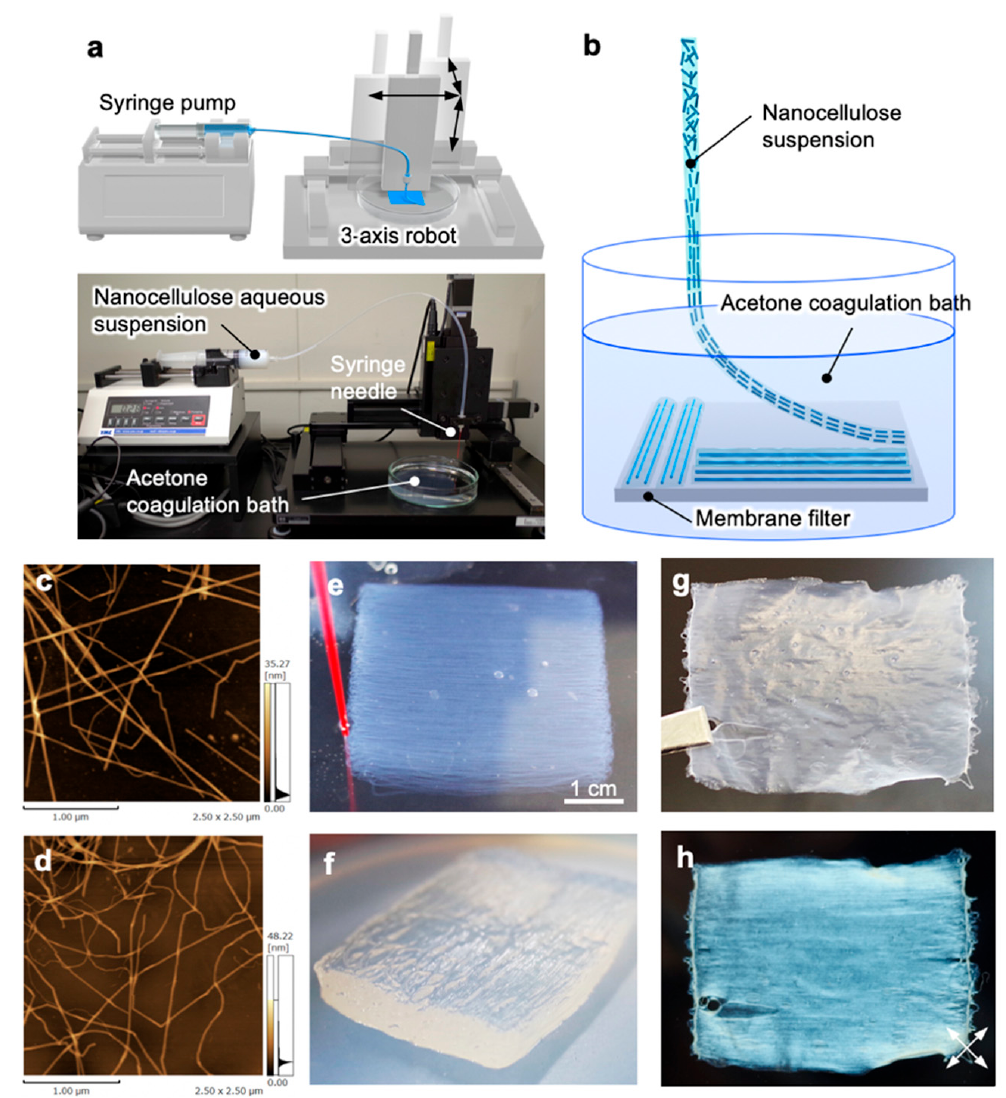
Figure 1. Liquid-phase 3D patterning of nanocelluloses. ( a ) Setup of the patterning system combining discharging of the nanocellulose suspension and patterning by the three-axis robot; ( b ) Conceptual illustration of patterning. SPM images of the ( c ) TNWs and ( d ) TNFs; ( e ) Nanocellulose gel during patterning in acetone; ( f ) Patterned nanocellulose gel removed from acetone; ( g ) Photograph and ( h ) crossed-Nicol view of the nanocellulose film after drying the patterned gel in ( f ) in an oven. The white double-headed arrows indicate the polarization axes.